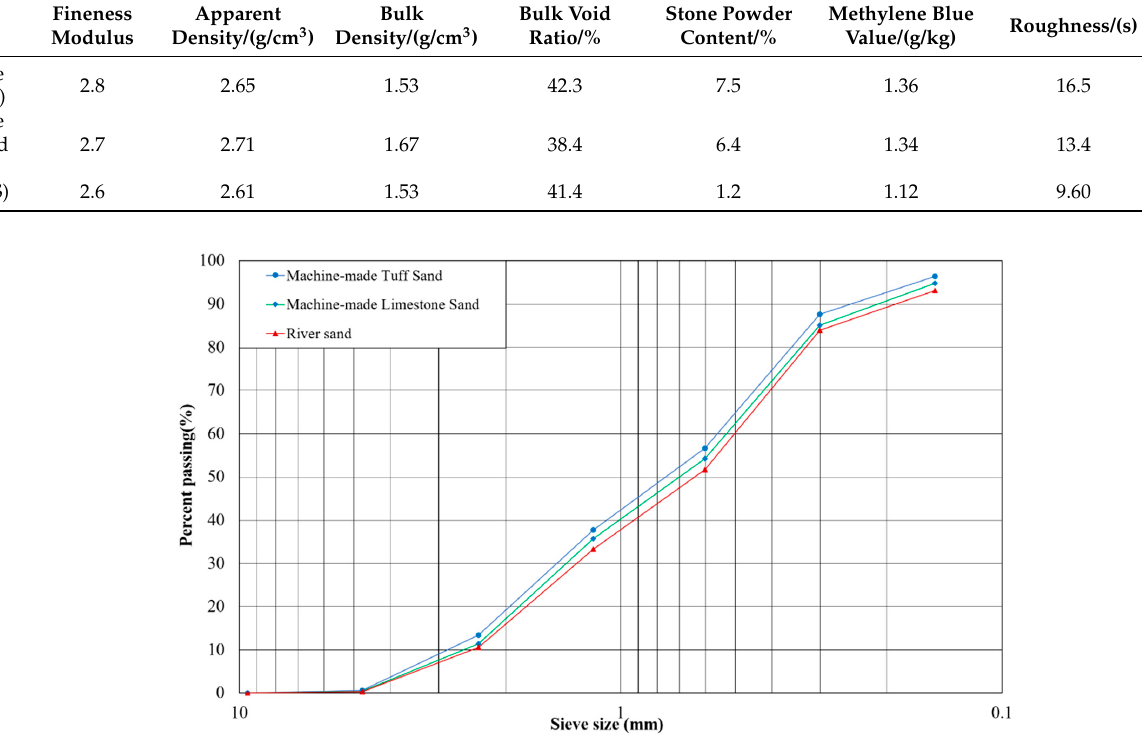
Figure 1. Fine aggregate grading curve.